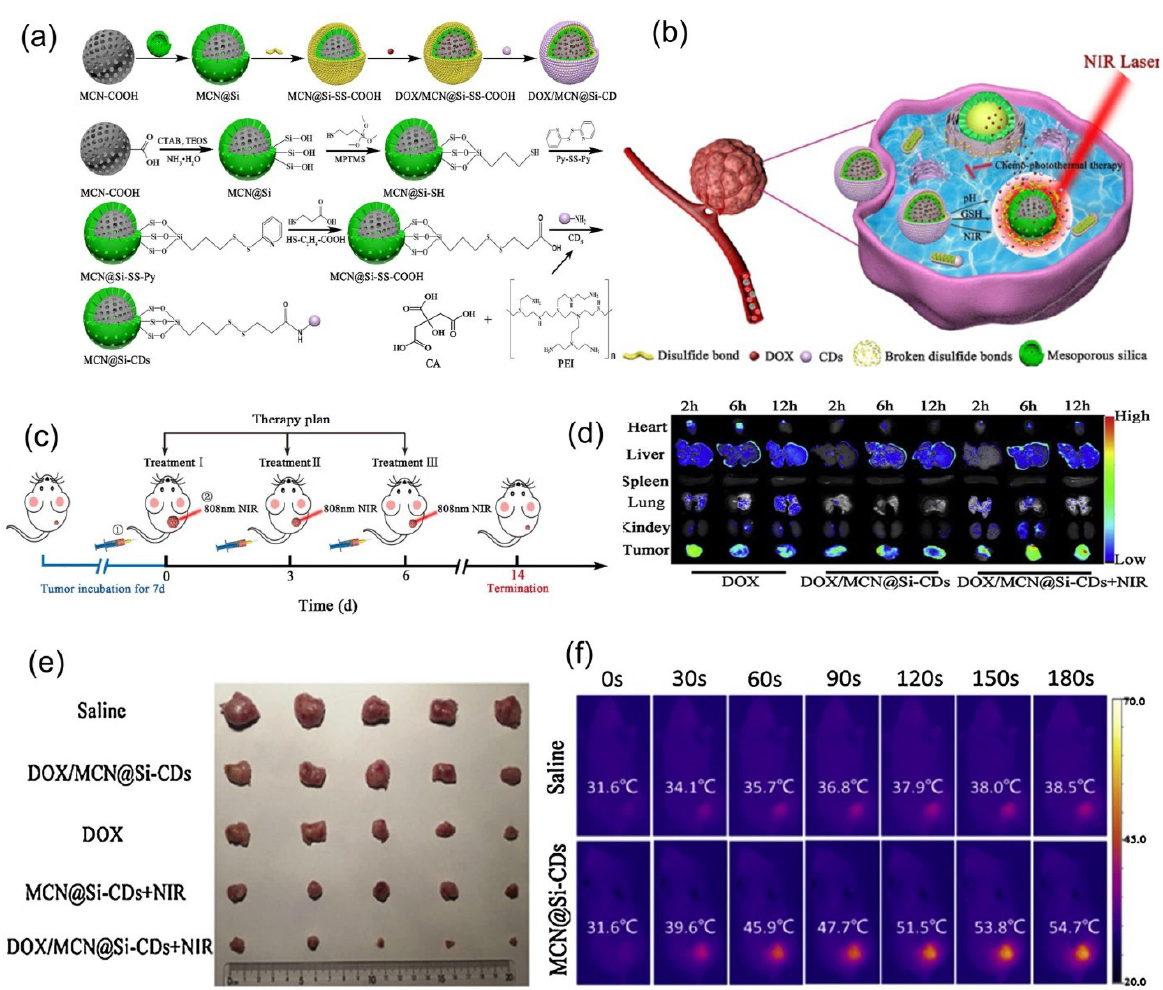
Figure 11. A nanoplatform made of a silica-coated carbon nanocomposite with redox/NIR/pH stimuli-responsive release ability and superior chemo-photothermal combined antitumor treatment activity. ( a ) Schematic illustration of synthesis of DOX/MCN@Si-CDs and MCN@Si-CDs. ( b ) Schematic illustration of chemo-photothermal combined antitumor treatment. ( c ) Schematic therapy plan for in vivo treatments: 1 (cid:13) intravenous injection in rat tail; 2 (cid:13) NIR tumor irradiation. ( d ) Organs and tumor fluorescence images. ( e ) Excised tumors images. ( f ) Mice thermal imaging photographs. Reproduced from [136], with permission from © 2020